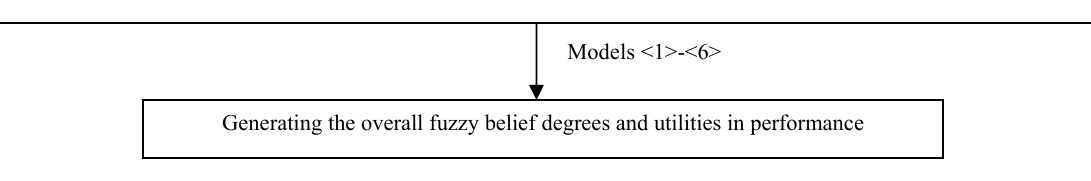
Fig. 10. Process of group evidential reasoning approach under fuzzy weights and utilities